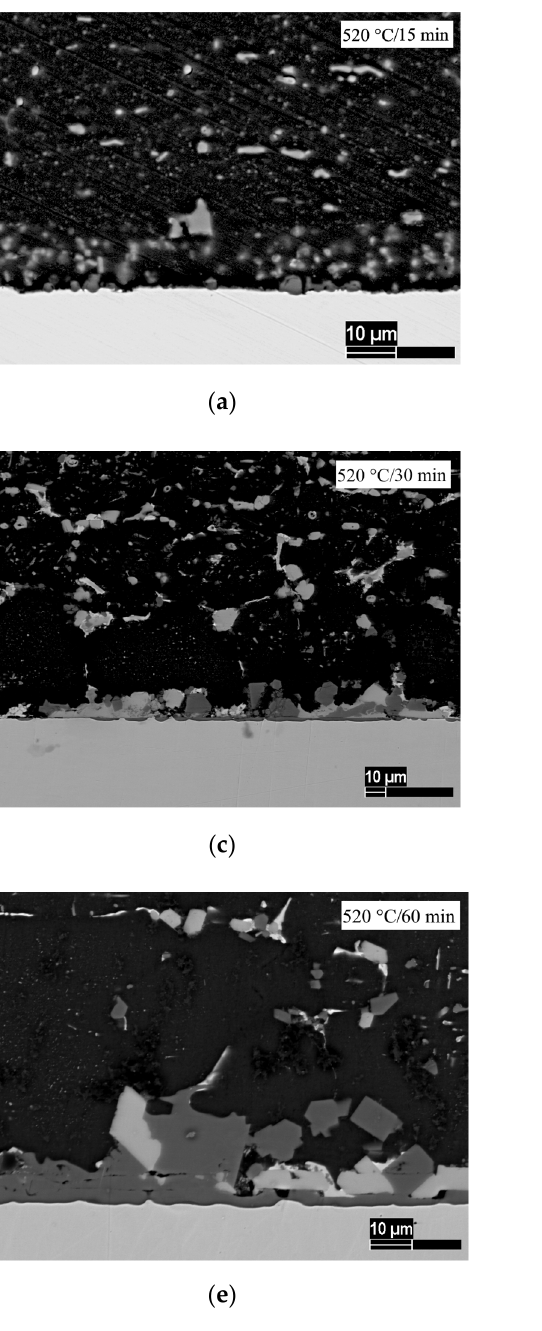
Figure 14. Microstructures of the AISI 304/AA6082 joints brazed according to the different modes obtained by SEM at 1000× magnification: ( a ) 520 °C/15 min; ( b ) 540 °C/15 min; ( c ) 520 °C/30 min; ( d ) 540 °C/30 min; ( e ) 520 °C/60 min; ( f ) 540 °C/60 min. Brazing at 540 °C and 520 °C with exposure for 15, 30, and 60 min was carried out to study the relationship between the time–temperature brazing modes and the characteris ‐ tics of the intermetallic compound reaction layer of AISI 304/AA 6082 brazed joints. Sam ‐ ples brazed according to the 520 °C/15 min mode showed the formation of the reaction